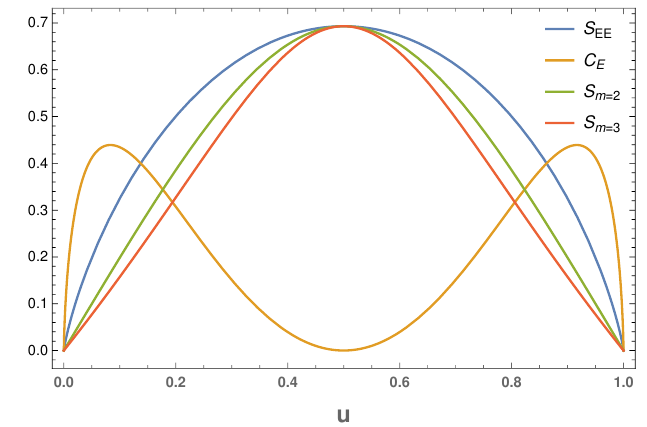
Figure 1. Variation of capacity, entanglement, and Rényi entropies with u . Note that the behavior of capacity is very different from the entanglement and Rényi entropies. Rényi and entanglement entropies reach maximum (at maximally entangled state) at u = 0 . 5 , where the capacity vanishes, while the capacity shows peaks in some intermediate partially entangled